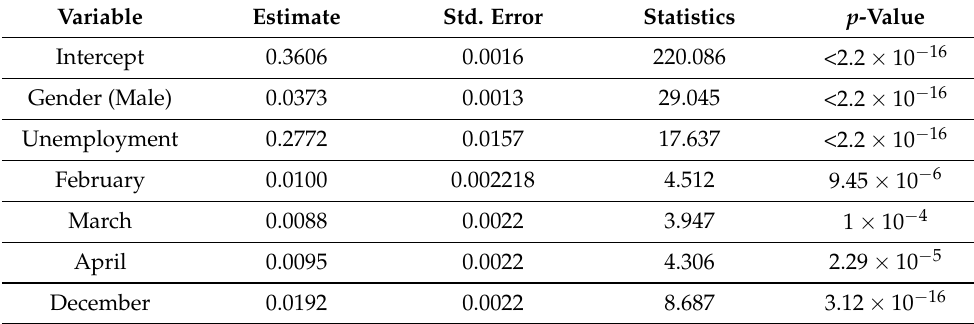
Table 2. Linear regression of Gini coefficient for all age groups.